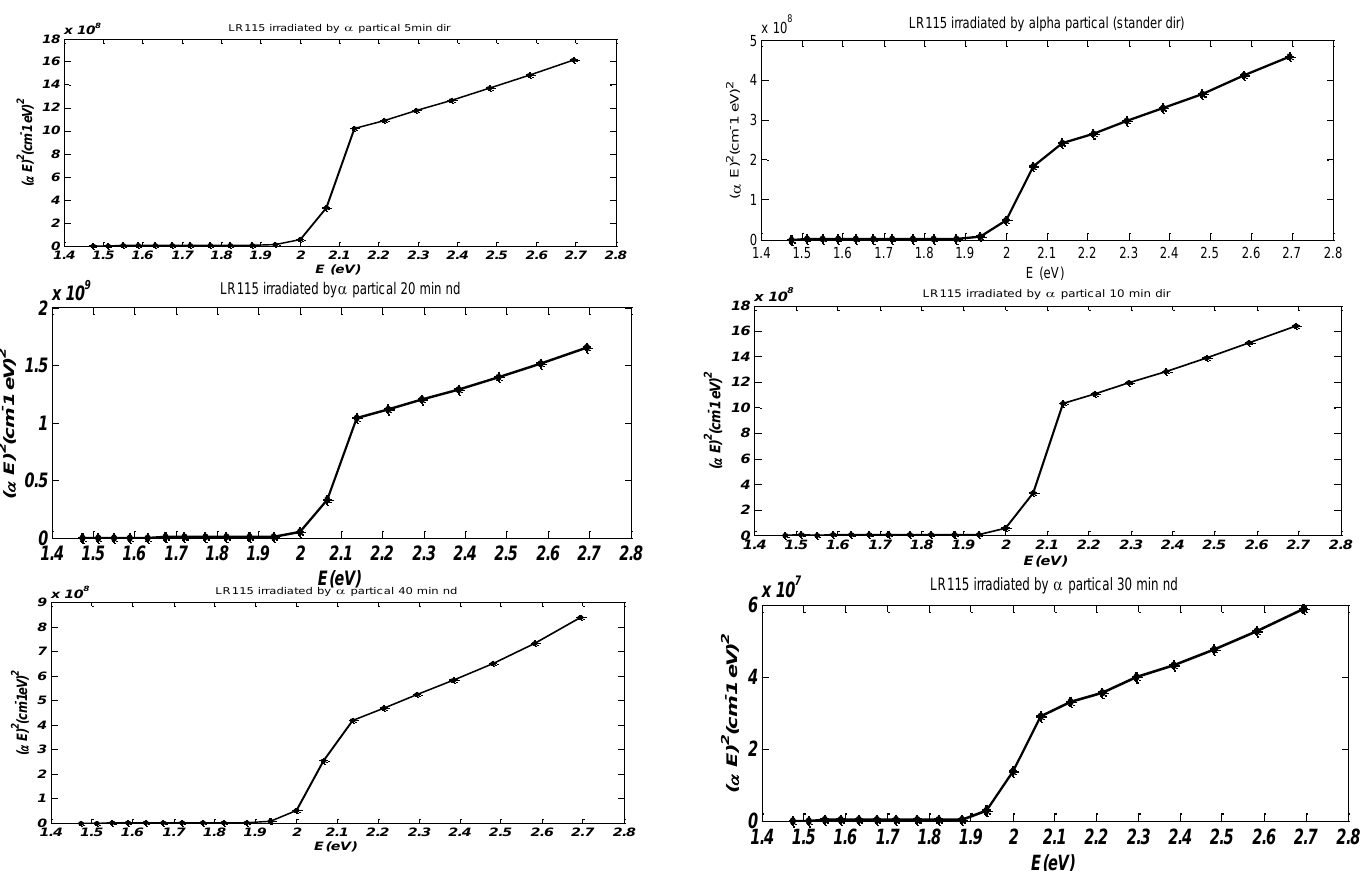
Fig.4: The dependence of((αhv) 2 on photon energy (hv) for pristine and alpha irradiated LR-115 polymer.